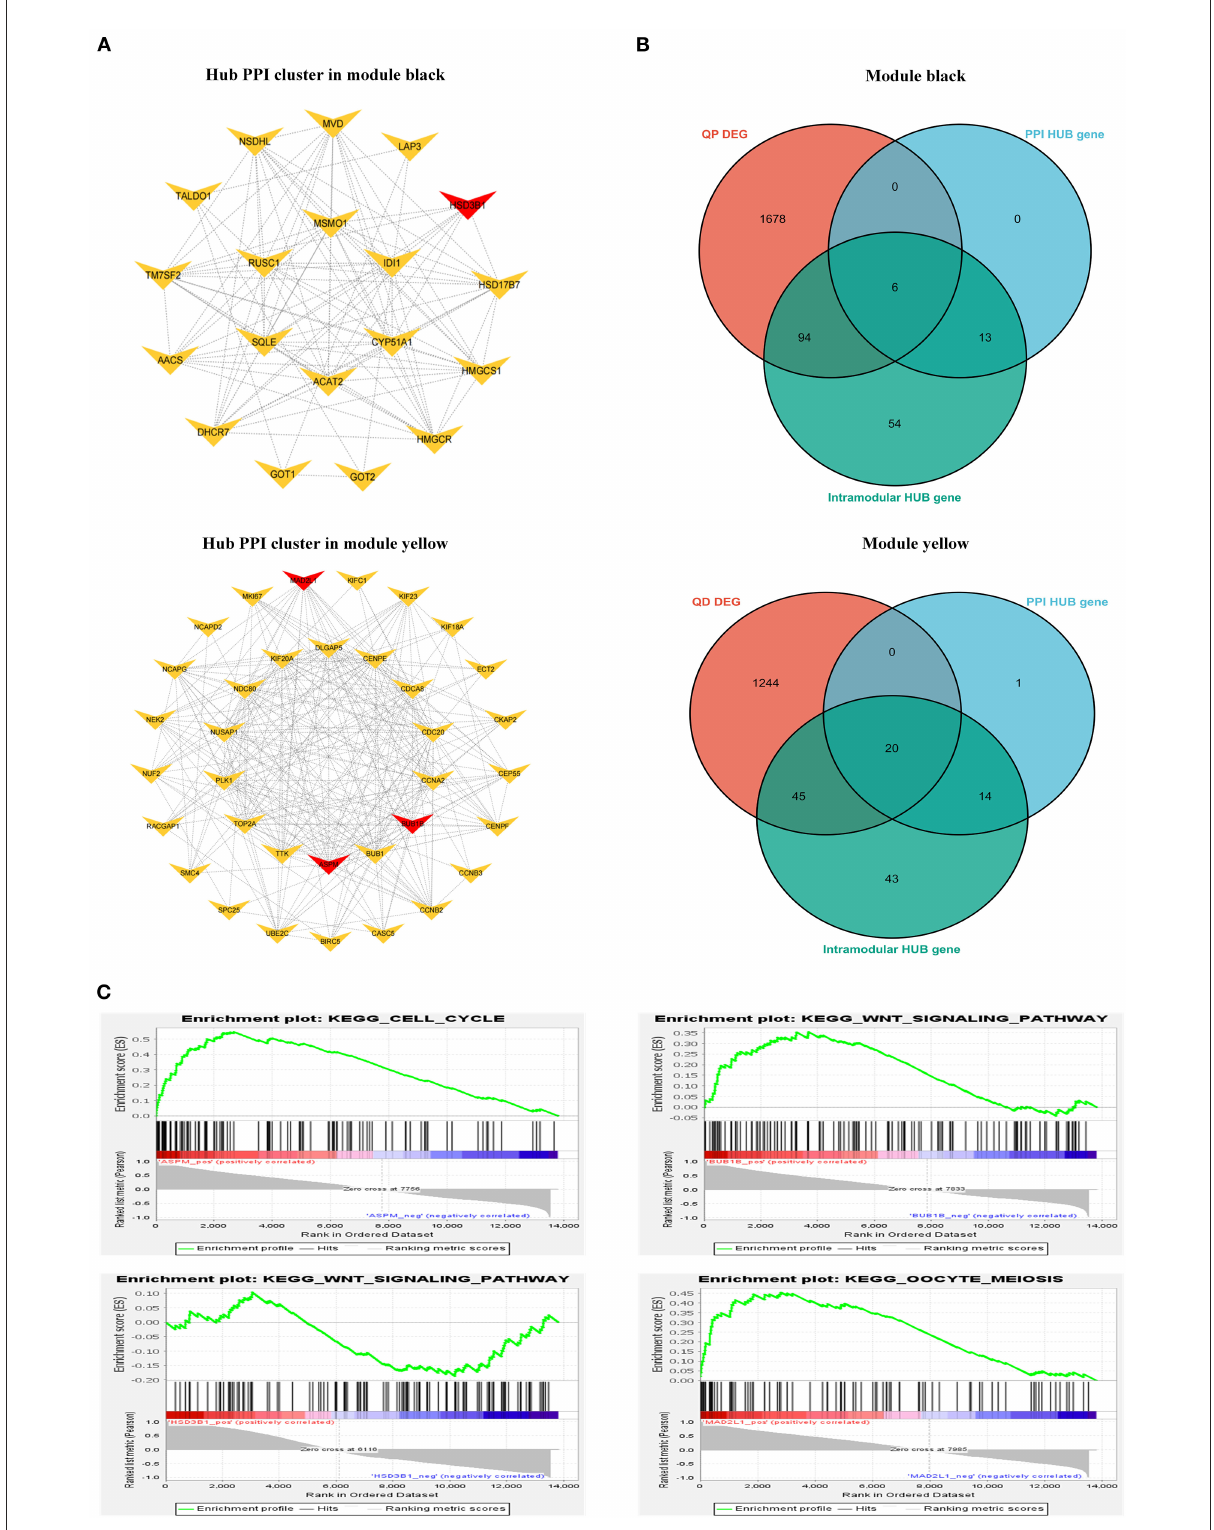
FIGURE10 Identification of hub genes. (A) Typical hub cluster of the PPI network in module black and yellow. (B) Wayne diagram of overlapped genes between PPI hub cluster genes, DEmRNAs and intra-module hub genes. (C) GSEA enrichment plots in BUB1B, MAD2L1, ASPM, and HSD3B1